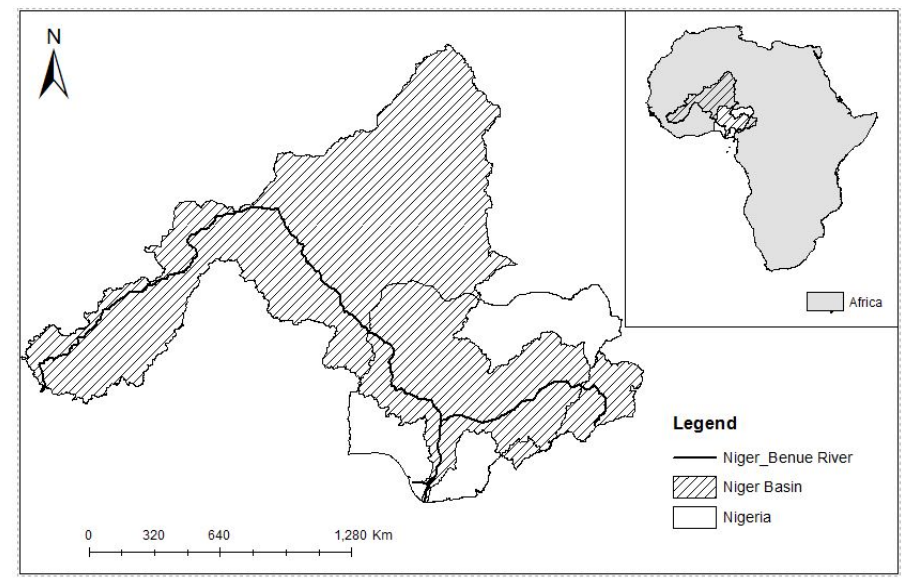
Figure 4. Map showing Nigeria, Niger Basin, Africa and the main inflow rivers (Niger and Benue).